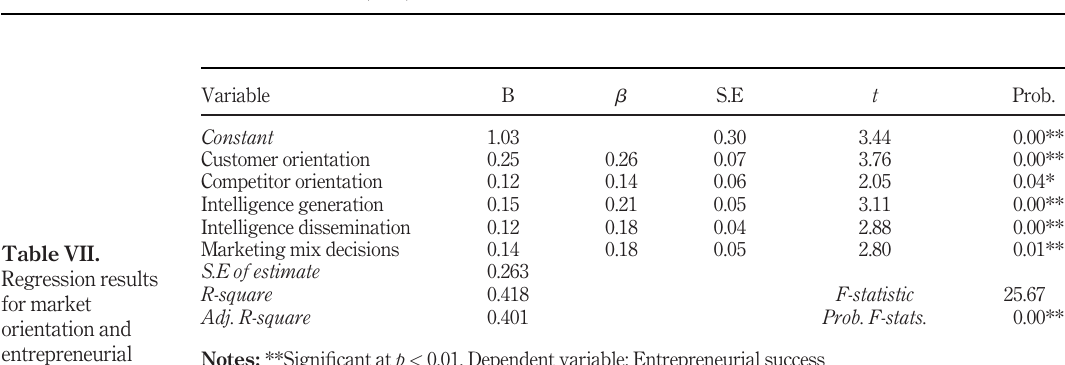
Table VII. Regression results for market orientation and entrepreneurial success